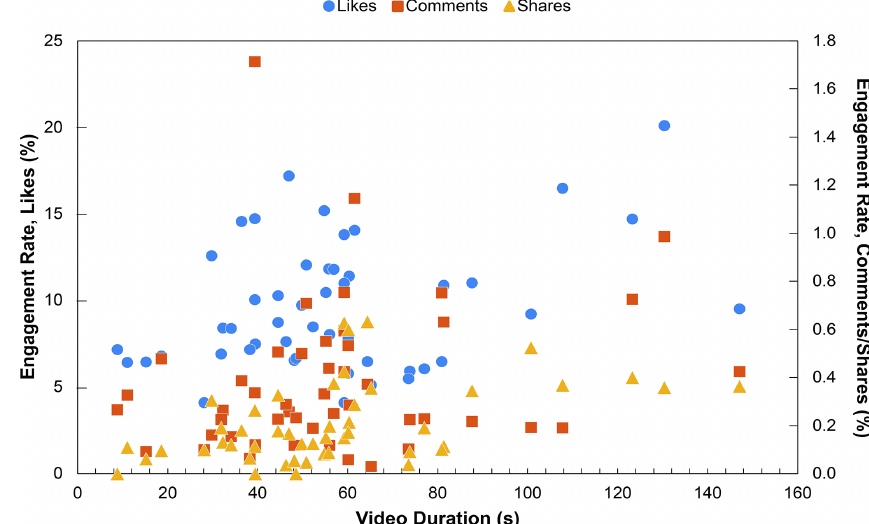
Figure 8. Engagement rates from each video compared with the duration of the video. Short videos under 20s have a lower overall engage- ment rate than longer videos do. There is a weak positive correlation that is statistically significant between the length of a video and the engagement rate of likes ( r = 0.34, p = 0.017) and a weak to moderate positive relationship that is statistically significant between video length and the engagement rate of shares ( r = 0.46, p = 0.001). There is no statistically significant correlation between video length and the engagement rate of comments ( p > 0.05). See Supplement for full correlation analysis.